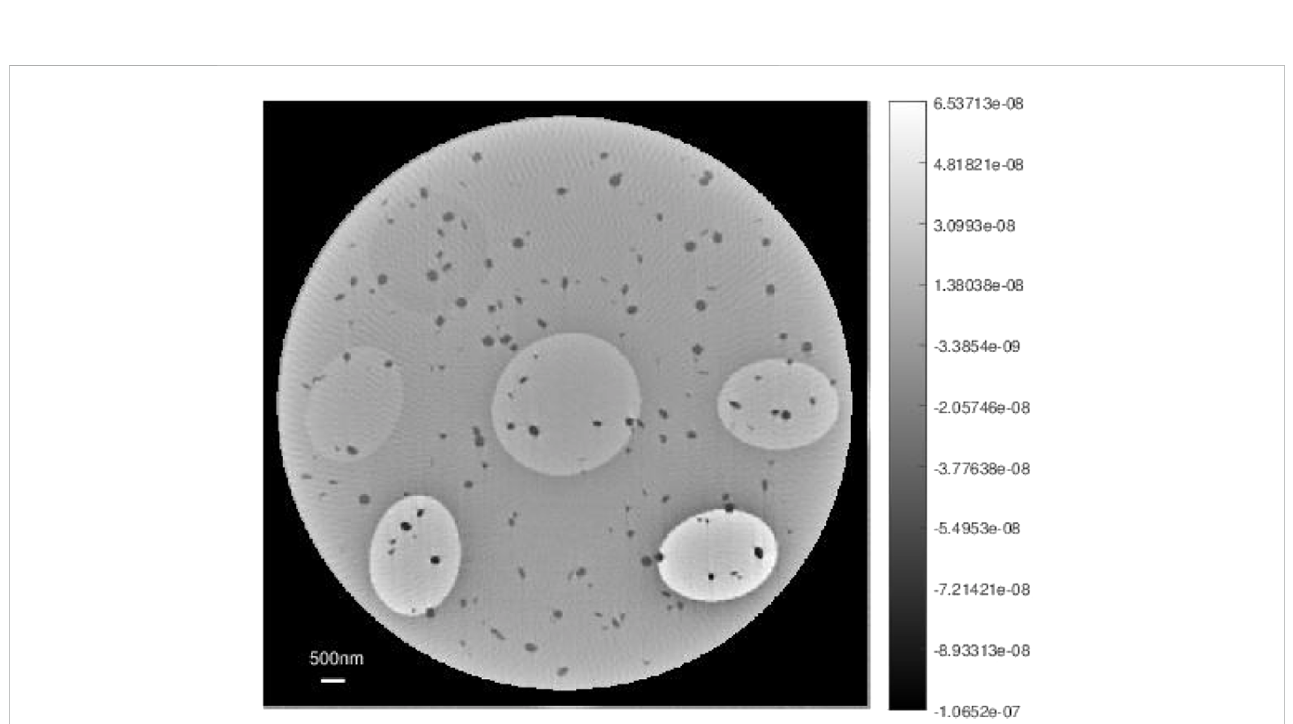
FIGURE 5 The inversion result using TFDM for noiseless